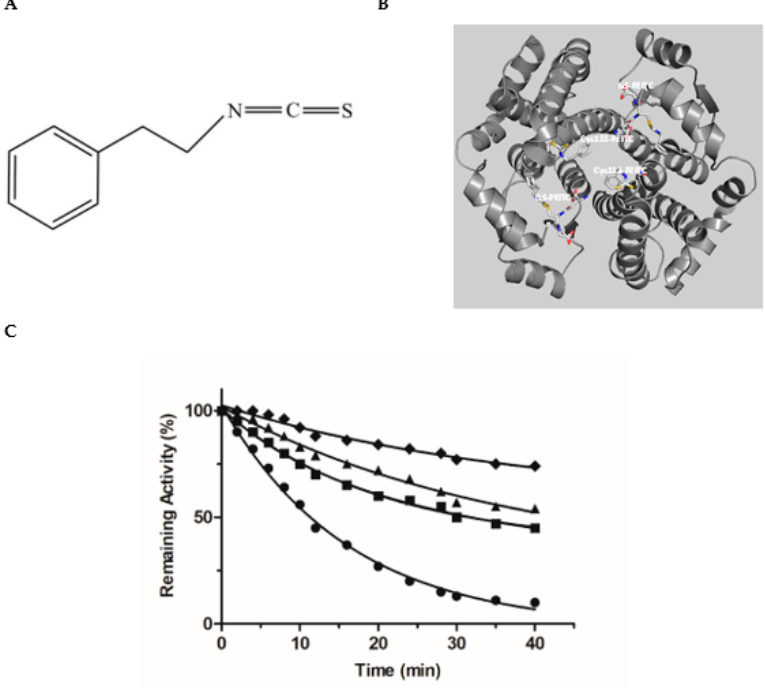
Figure 4. ( A ) The structure of PEITC. ( B ) The interaction of the Cys112-PEITC and the GS-PEITC (the adduct formed between GSH and PEITC) with hGSTA1–1 (PDB entry 5JCU). The Cys112- PEITC and GS-PEITC adducts are illustrated as sticks and the protein structure as a ribbon diagram. Nitrogen atoms are shown in blue, oxygen in red, and sulfur in yellow. ( C ) Time course of the hGSTA1–1 inactivation by PEITC: 0.5 mM PEITC ( ● ); 0.5 mM PEITC in the presence of S-nitroben- zyl-GSH (1 mM, ■ ); 0.5 mM PEITC in the presence of MYR (10 μΜ , ▲ ); 0.5 mM PEITC in the pres- ence of MYR (20 μΜ , ♦ ). Incubation of hGSTA1–1 with PEITC, leads to a time-dependent loss in enzyme ac- tivity, as expected for an irreversible inhibitor (Figure 4C). Incubation of hGSTA1–1 with PEITC in the presence of the inhibitors MYR or S-nitrobenzyl-GSH, diminishes the rate of enzyme inactivation (k obs ) (Table 1). The presence of MYR or S-nitrobenzyl-GSH in the incubation mixture appears to protect the enzyme from inactivation by PEITC, suggesting that these compounds compete with PEITC for binding to the same site. Table 1. Observed rates and half-time of hGSTA1–1 inactivation by PEITC in the presence of the competing ligands S-nitrobenzyl-GSH and MYR. Competing Ligand